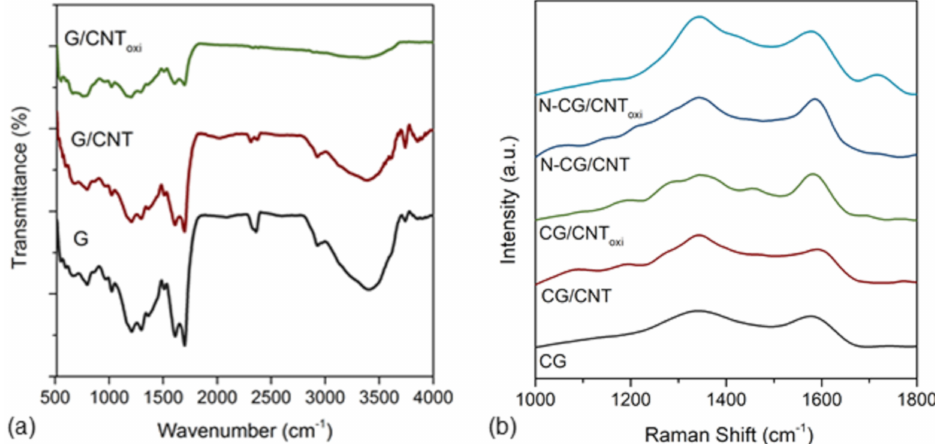
Figure 3. ( a ) FTIR spectra of hydrothermal glucose prepared without CNT (G) and in the presence of CNT (G / CNT) and CNT oxi (G / CNT oxi ) and ( b ) Raman spectra of carbonized glucose and undoped and N-doped carbon composites prepared by introducing CNT and oxidized